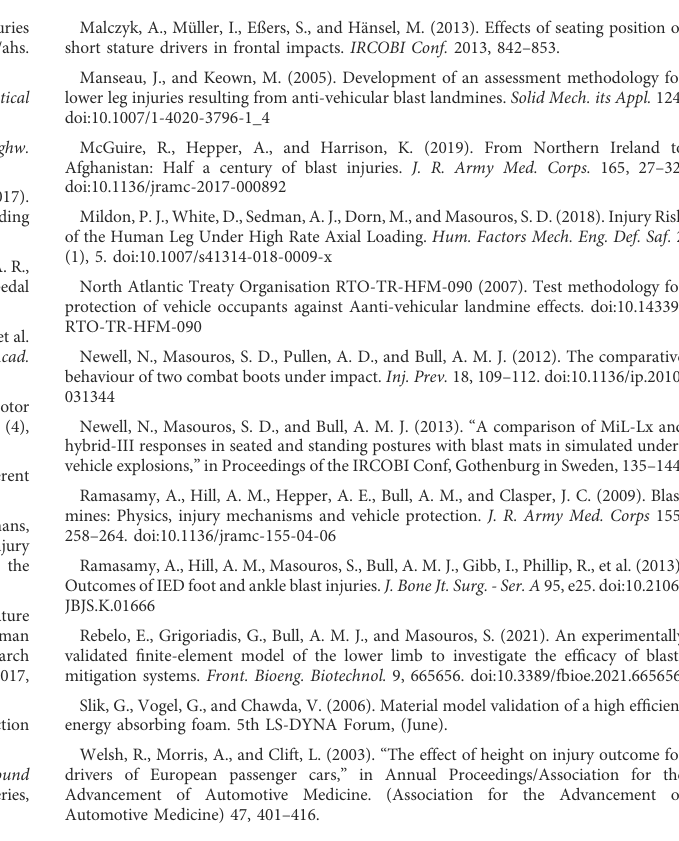
SUPPLEMENTARY FIGURE S1 Deformationplotsfor simulationcon fi gurations (A) unreformed, (B) sim 1;5 m/ s in 1.5 ms, (C) sim 6; 11.5 m/s in 1.5 ms, and (D) sim 11; 17.5 m/s in 1.5 ms, all with the combat boot and without the fl oor mat. SUPPLEMENTARY FIGURE S2 Deformationplotsfor simulationcon fi gurations (A) unreformed, (B) sim 1;5 m/ s in 1.5 ms, (C) sim 6; 11.5 m/s in 1.5 ms, and (D) sim 11; 17.5 m/s in 1.5 m/s, all with the combat boot and the IMPAXX ™ fl oor mat. SUPPLEMENTARY TABLE S1 Raw data per simulation with which Figure 3 was produced. The input in the simulation was a triangular pulse de fi ned by the maximum velocity (vmax) and the time to maximum velocity or time to peak (TTP). The output from the simulations was the tibial peak force (Fmax). The peak force was then used to lookuptheriskofaminororamajorcalcanealinjuryonChirvietal. ’ sinjuryrisk